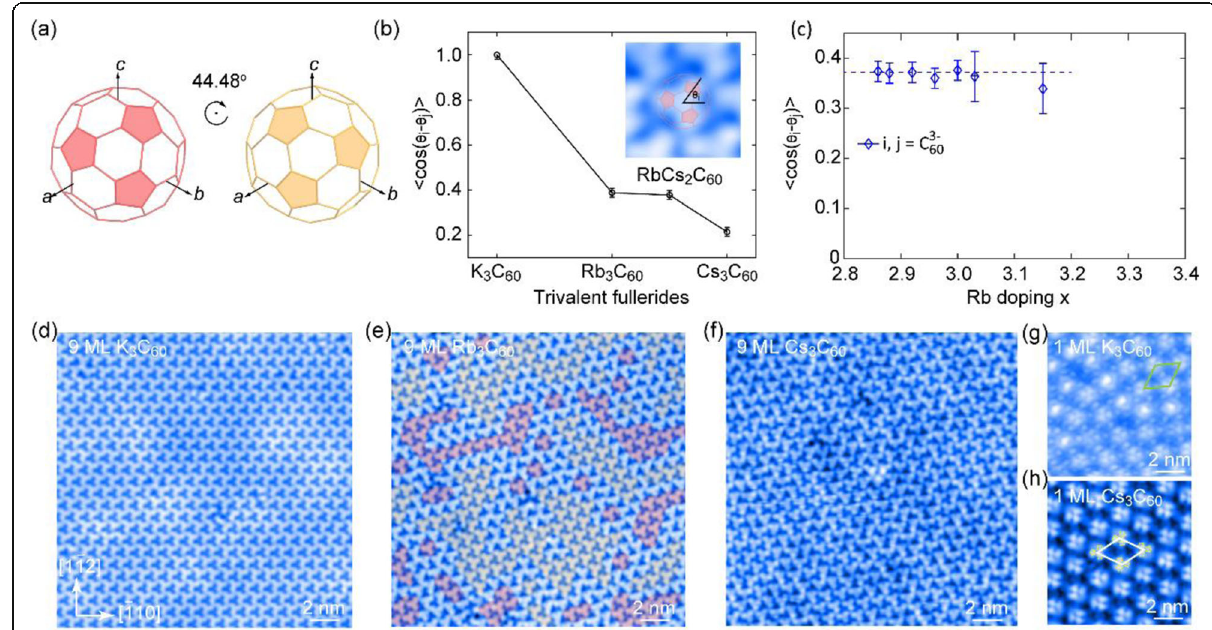
Fig. 4 Orientational orderings in A 3 C 60 films. ( a ) Two standard C 60 orientations viewed along the [51] direction. ( b ) Orientational correlation in 9 ML A 3 C 60 films. Inset shows the definition of θ i . ( c ) Averaged orientational correlation in 9 ML Rb x C 60 films as a function of doping x . ( d - f ) STM topographies of 9 ML A 3 C 60 films. ( g , h ) STM topographies of monolayer K 3 C 60 and Cs 3 C 60 films revealing a √ 3 × √ 3 superstructure. Taken from ref. [44 –